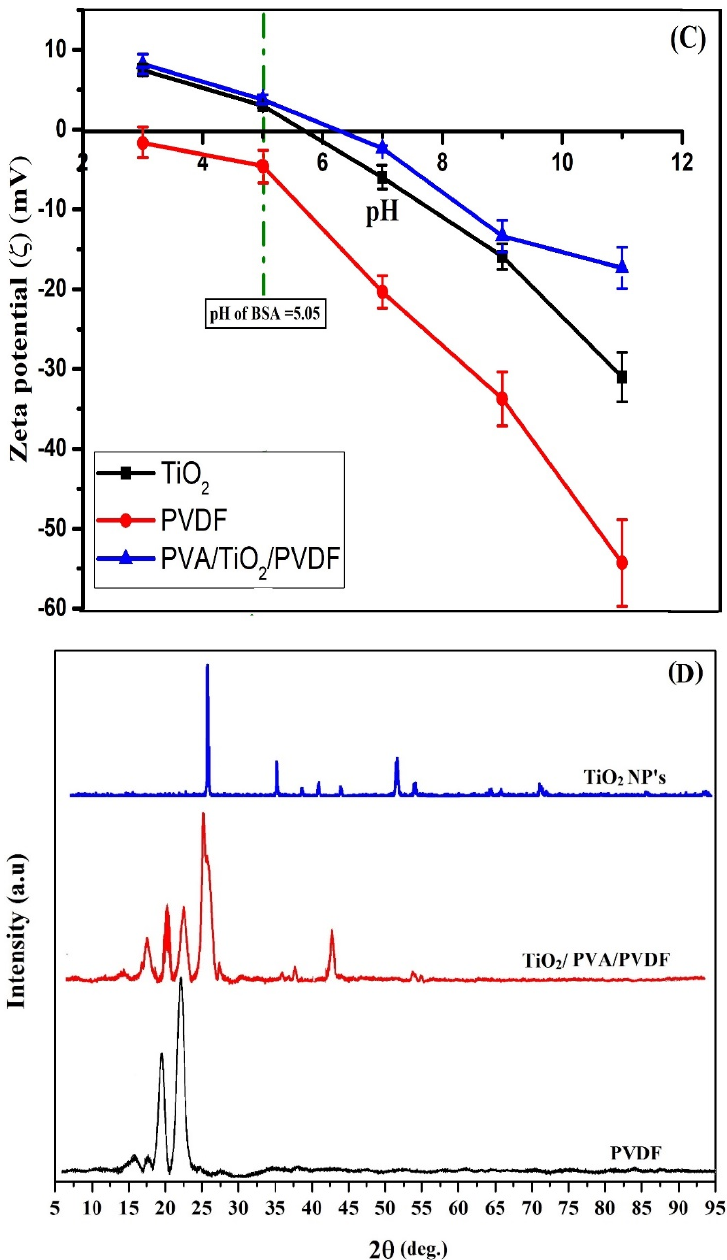
Figure 5. Effect of TiO 2 loading ( A ) Contact angle of the membranes; ( B ) FTIR spectra of plain and modified PVDF membranes; ( C ) Zeta potential values at different pH for TiO 2 , plain PVDF and 1 wt.% TiO 2 /PVA modified PVDF membrane; ( D ) XRD pattern of TiO 2 nanoparticles, plain and modified (for 1 wt.% TiO 2 ) PVDF membranes.